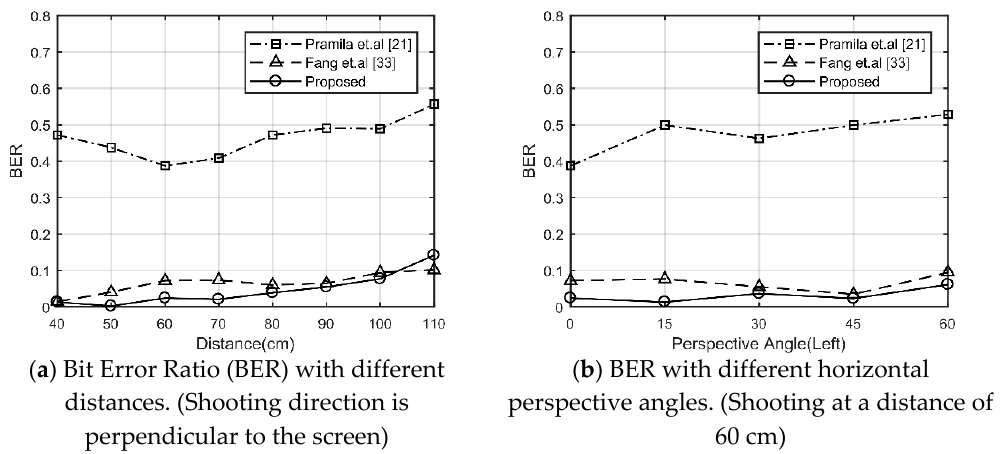
Figure 15. Comparison of different methods for different shooting conditions.